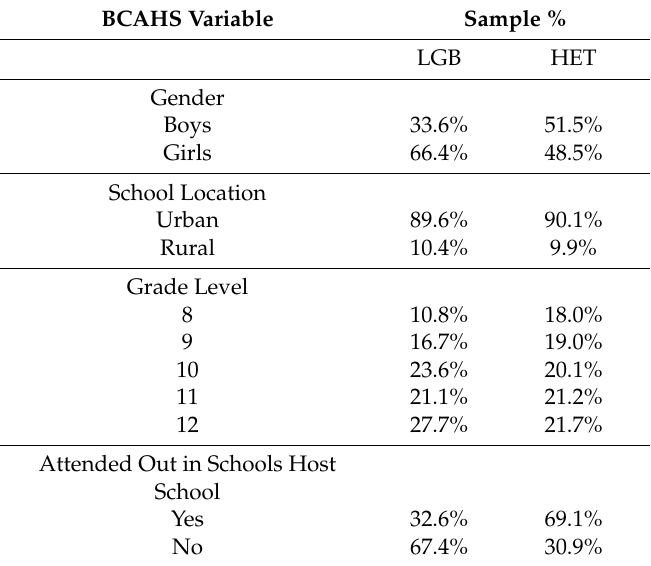
Table 2. Lesbian, gay, bisexual and completely heterosexual student samples in the 2013 BC Adolescent Health Survey (BCAHS), unweighted N = 21,075, weighted and scaled * N = 184,821. BCAHS Variable Sample % LGB HET Gender Boys 33.6% 51.5% Girls 66.4% 48.5% School Location Urban 89.6% 90.1%